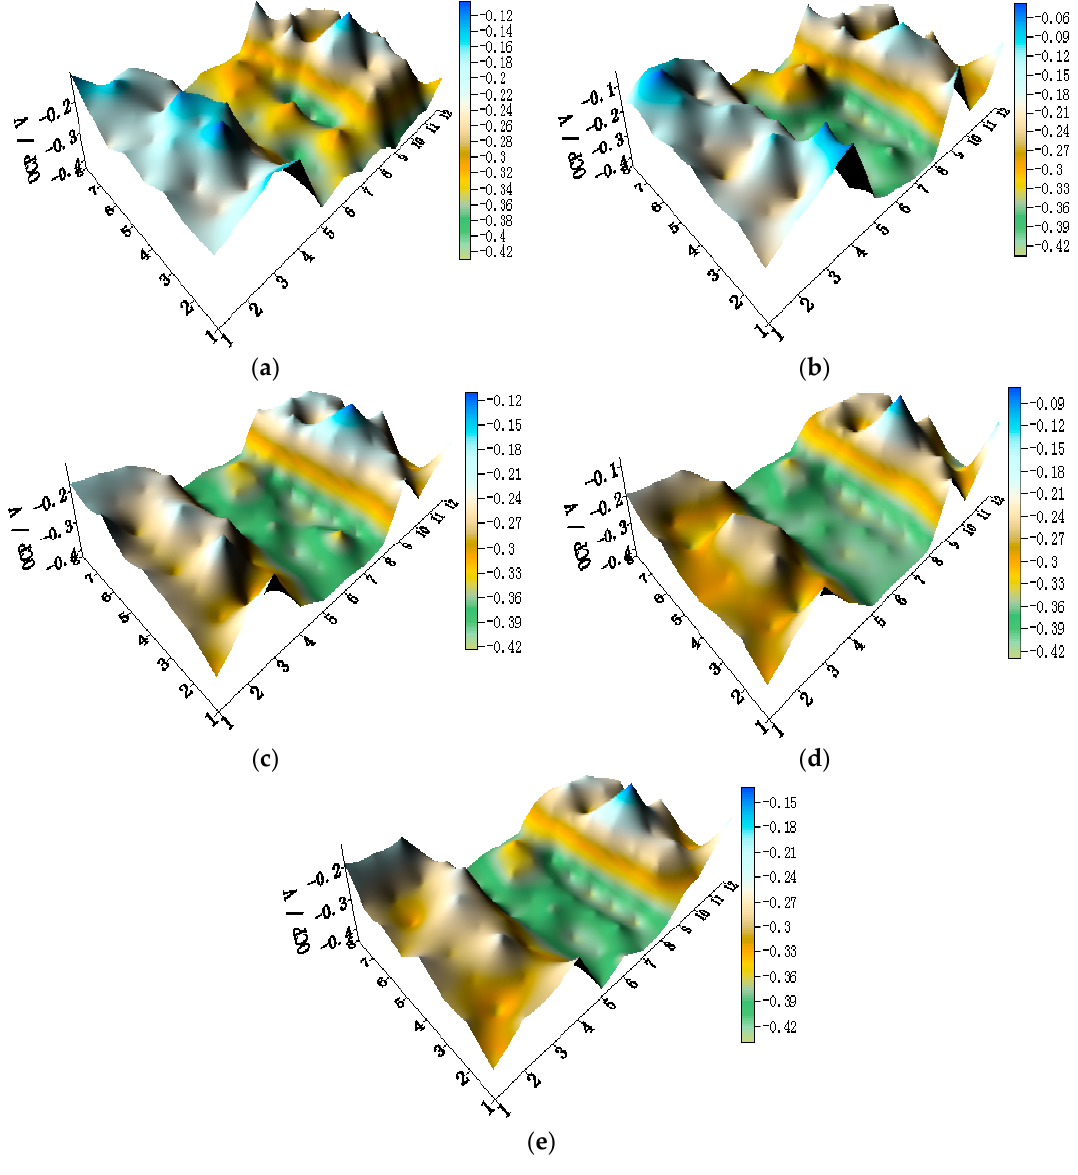
Figure 11. OCP (vs. SCE/V) distribution maps of the WBE3 after immersion in artificial seawater at different temperatures: ( a ) 30 °C; ( b ) 40 °C; ( c ) 50 °C; ( d ) 60 °C; and ( e ) 70 °C.